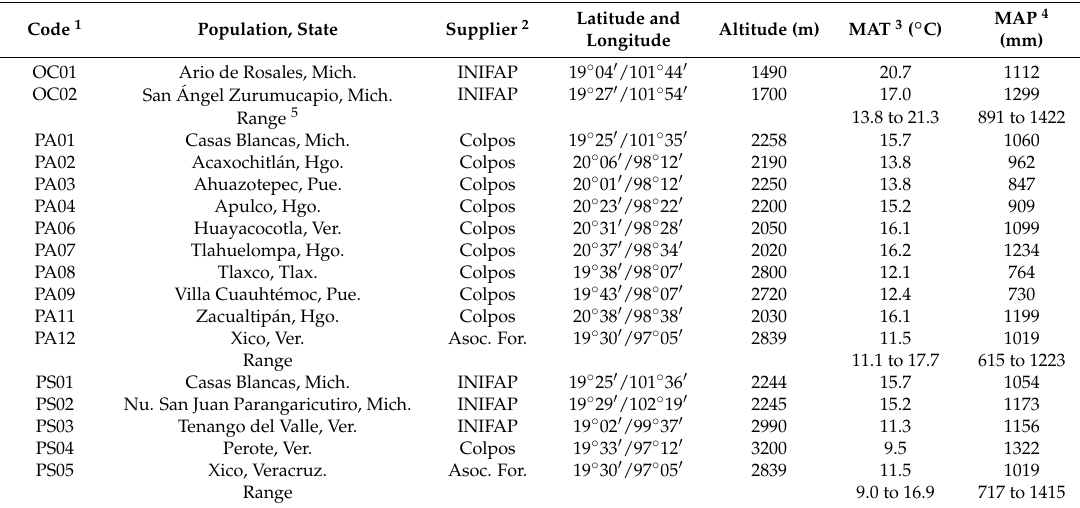
Table 1. Location and general characteristics of the Pinus spp. populations sampled in Mexico. Code